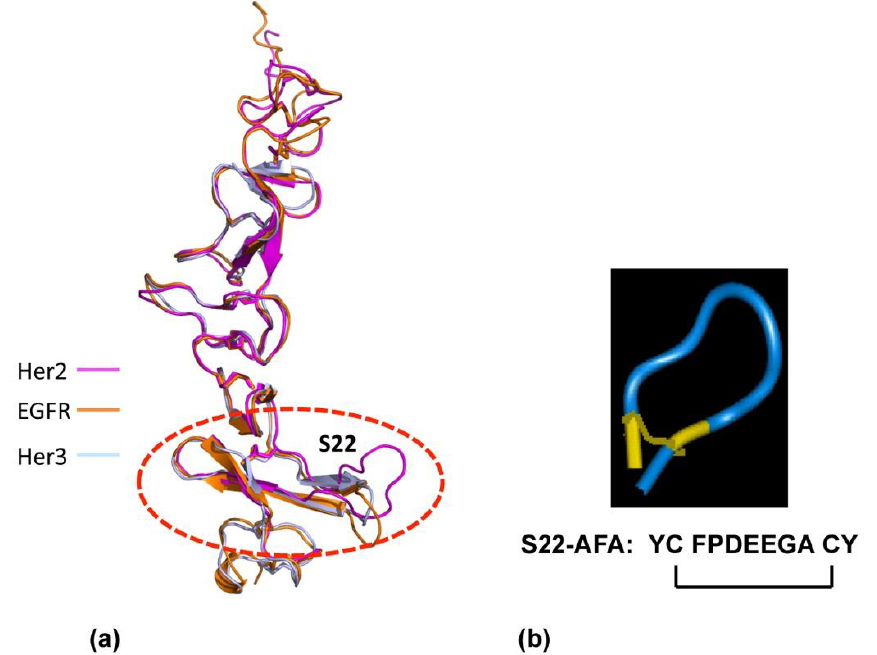
Figure 3. Design of ErbB dimerization inhibitor. ( a ) Structural similarity of the membrane-proximal domain SbdIV in EGFr, Her2, and Her3 is shown. ( b ) Designed molecular structure of S22-AFA is shown. Disulfide links are shown in yellow.